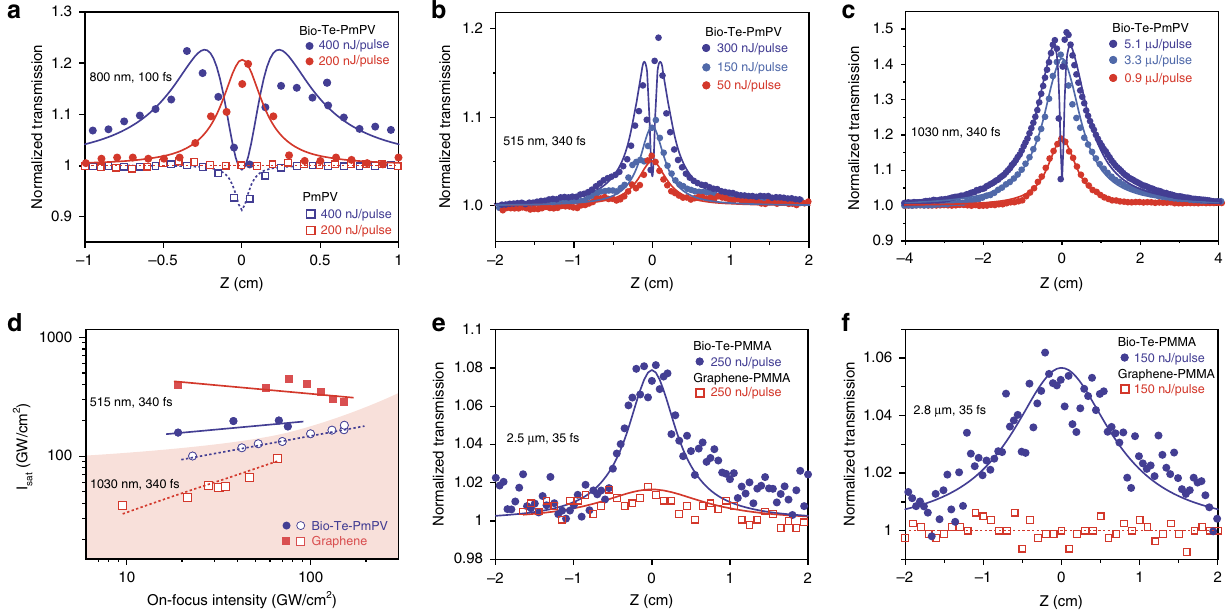
Fig. 2 Open-aperture z-scan results of the biological synthesized tellurium samples. a Experimental results with fs pulses, 800 nm. Bio-Te-PmPV (solid circles); PmPV (hollow squares). Solid lines: fi tted z-scan curves using equation (1); Dashed lines are for visual guide. b , c Experimental results with 340 fs laser at 515 nm ( b ) and 1030 nm ( c ). d Saturated intensity I sat of Bio-Te-PmPV and graphene dispersion as functions of the laser intensity at 1030 nm and 515 nm. e , f Mid-infrared open z-scans of Bio-Te and graphene polymethyl methacrylate (PMMA) fi lms at 2.5 μ m and 2.8 μ m wavelengths, showing